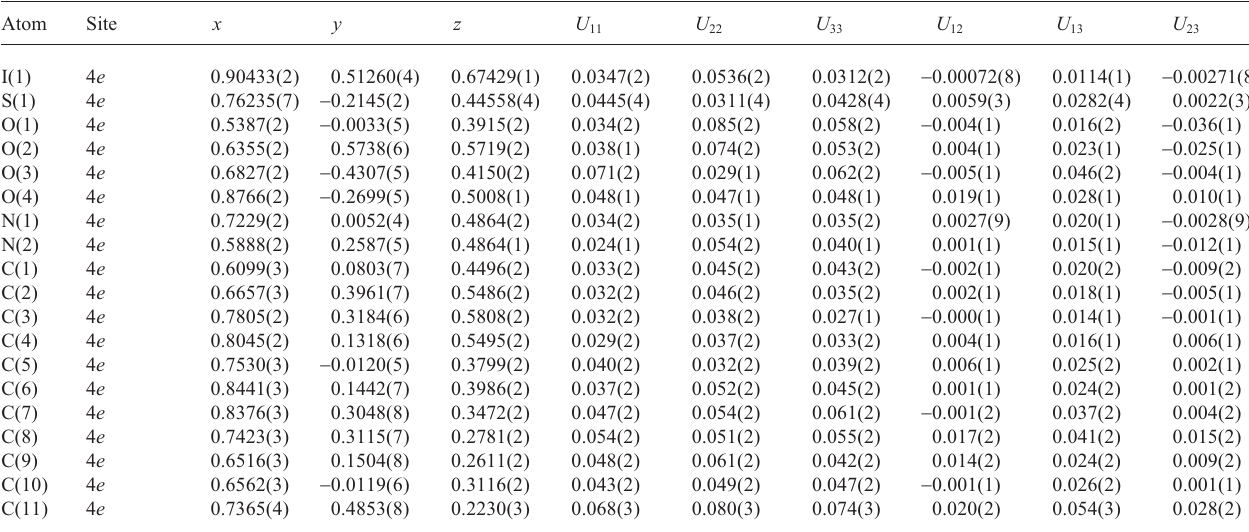
Table 3. Atomic coordinates and displacement parameters (in Å 2 )